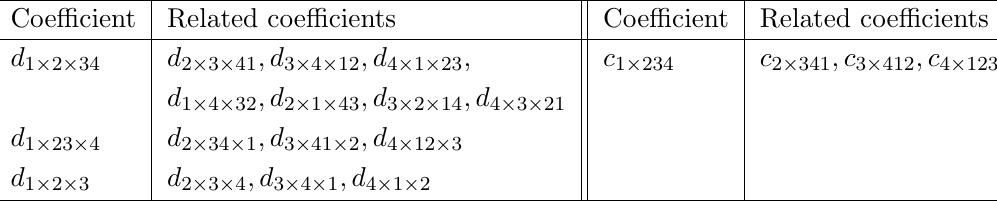
Table 1 . Minimal set of integral coe(cid:14)cients for 1 +